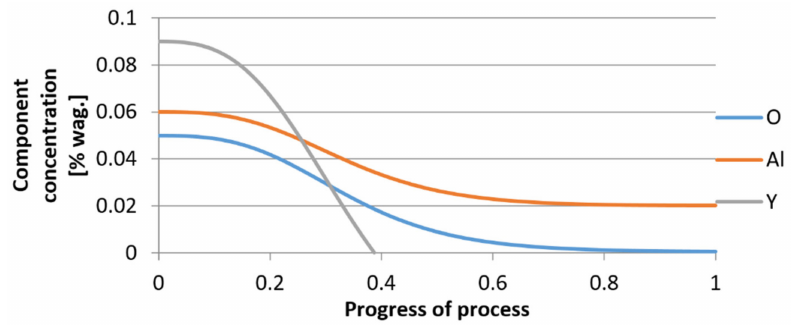
Figure 16. Change in component concentration during bi-component nucleus growth (Al 2 O 3 –Y 2 O 3 ) in steel 1 (for r 0 = 1 µ m).